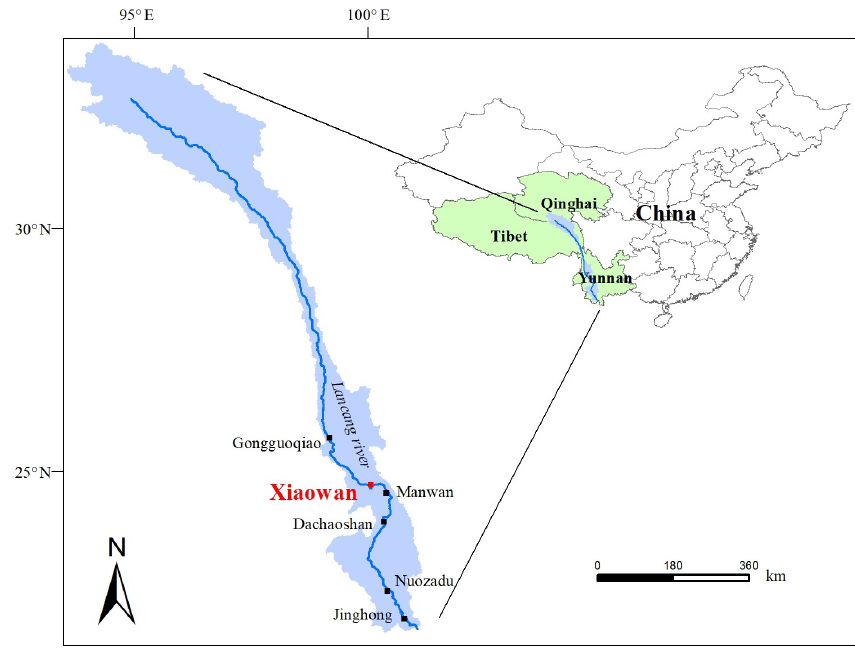
Figure 2. Location of the Xiaowan hydropower station.